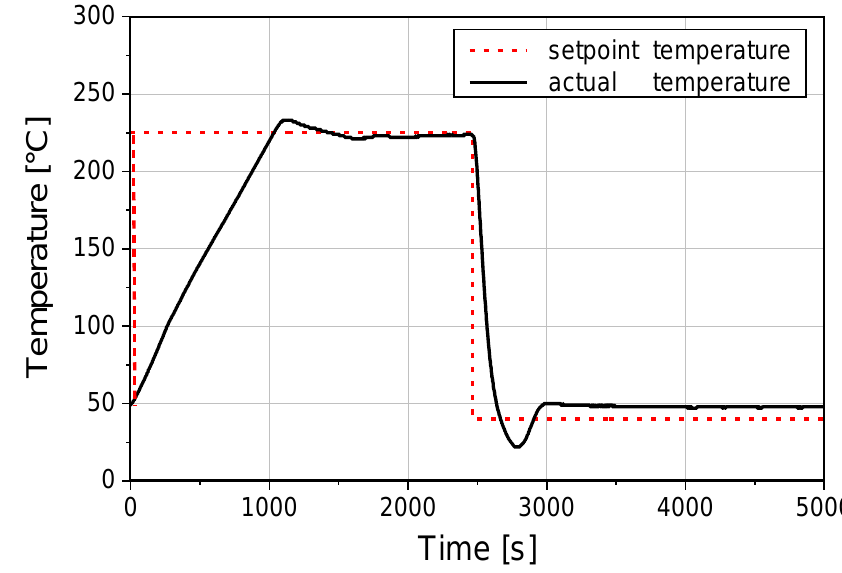
Figure 4. Set heating rate and the resulting actual temperature of the compression molding process.